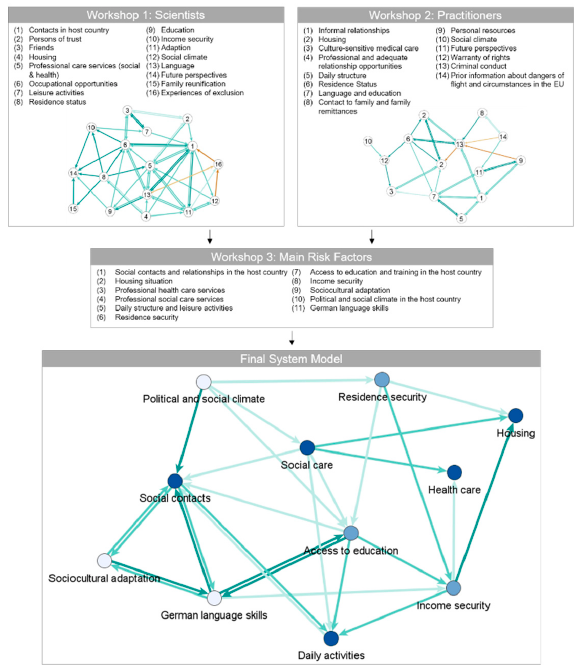
Figure 2. Illustrations depict the system models of post-migration factors developed in workshops 1 and 2. The main factors identified in workshop 3 are illustrated in the center, and the final system model developed throughout the three workshops can be seen